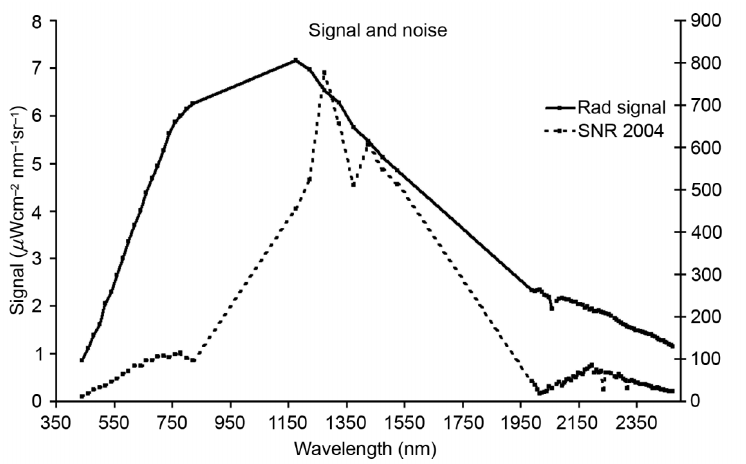
Fig. 1. MIVIS SNR @ 25 Hz, plus the radiance values from which it has been